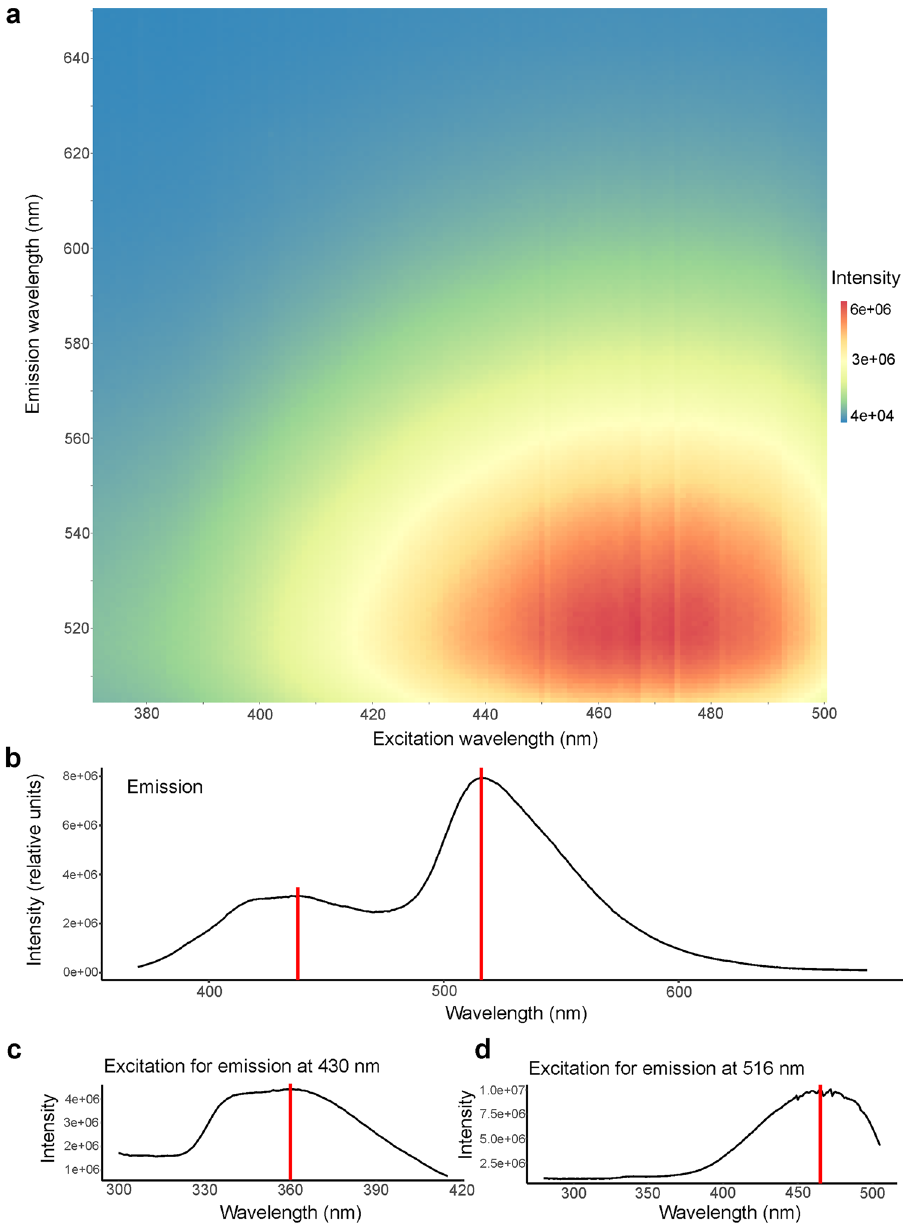
Figure 2. Excitation and emission spectra of fluorescence from the ventrolateral skin of Pachydactylus rangei . ( a ) Excitation-emission matrix (intensity in arbitrary units). ( b ) Emission spectrum with the maximum at 516 nm (neon-green) and smaller peak with a maximum around 430 nm (blue); both indicated by a red line. ( c ) Excitation spectrum for the smaller emission peak at 430 nm with the maximum at 360 nm (in the UV-A spectrum) indicated by a red line. ( d ) Excitation spectrum for the emission peak at 516 nm with the maximum at 465 nm (blue) indicated by a red